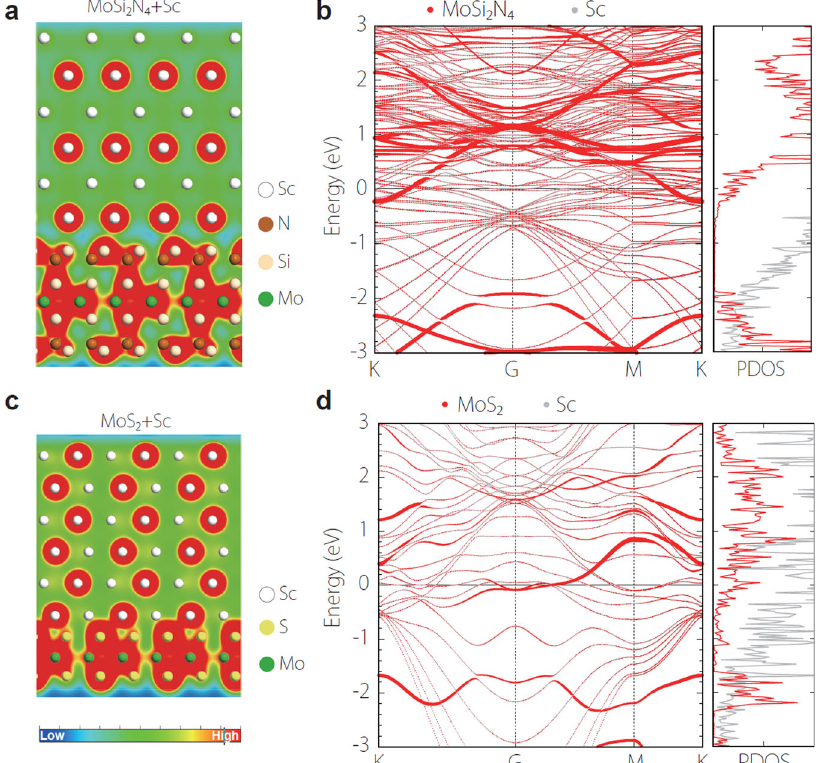
Fig. 4 Comparing Sc contacts to MoSi 2 N 4 MoS 2 . a Contour plots of total electron distribution of Sc/MoSi 2 N 4 . b Band structure and projected density of states of Sc/MoSi 2 N 4 . c , d Same as b and c , respectively, but for Sc/MoS 2